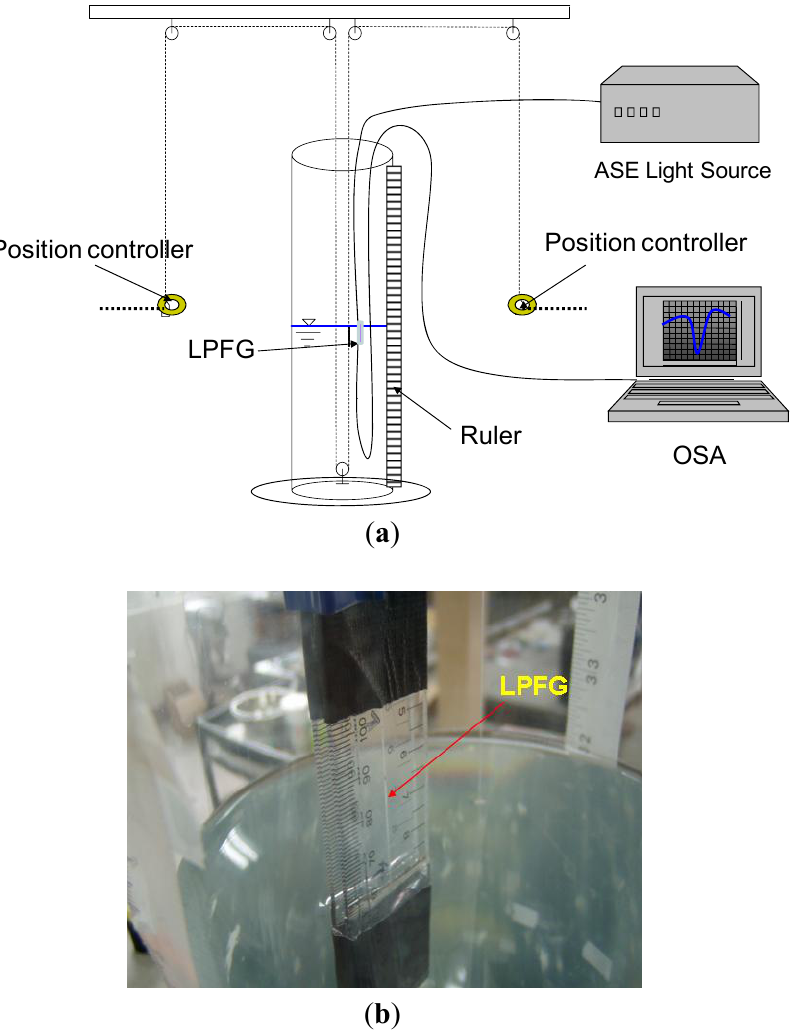
Figure 1. ( a ) Experimental setup for a mobile LPFG-based liquid level sensor with a 1,546.25-nm resonance wavelength LPFG and the whole LPFG was completely